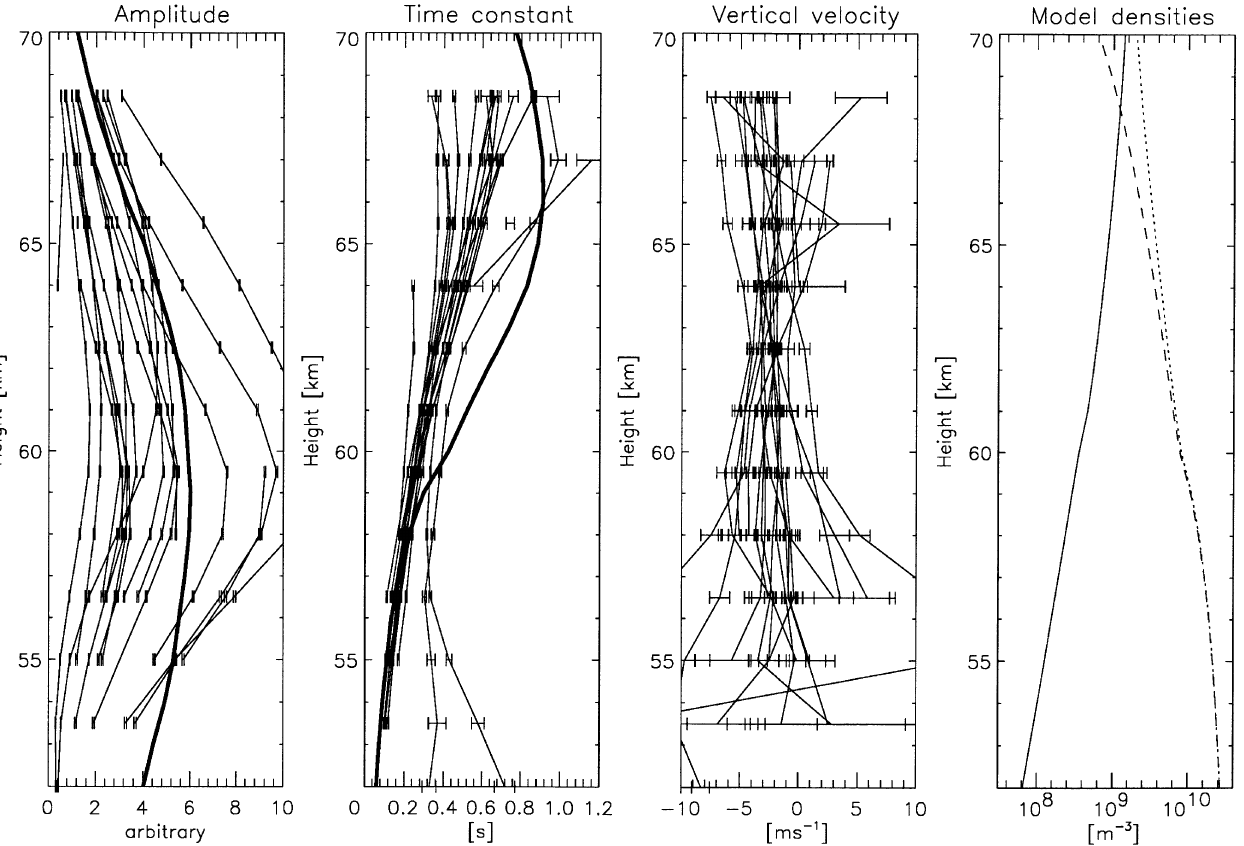
time-constant from the Sodankyla¨ ion-chemistry model. The fourth panel shows the electron density ( solid line ), positive-ion density ( dotted line ) and negative-ion density ( dashed line ) used in the